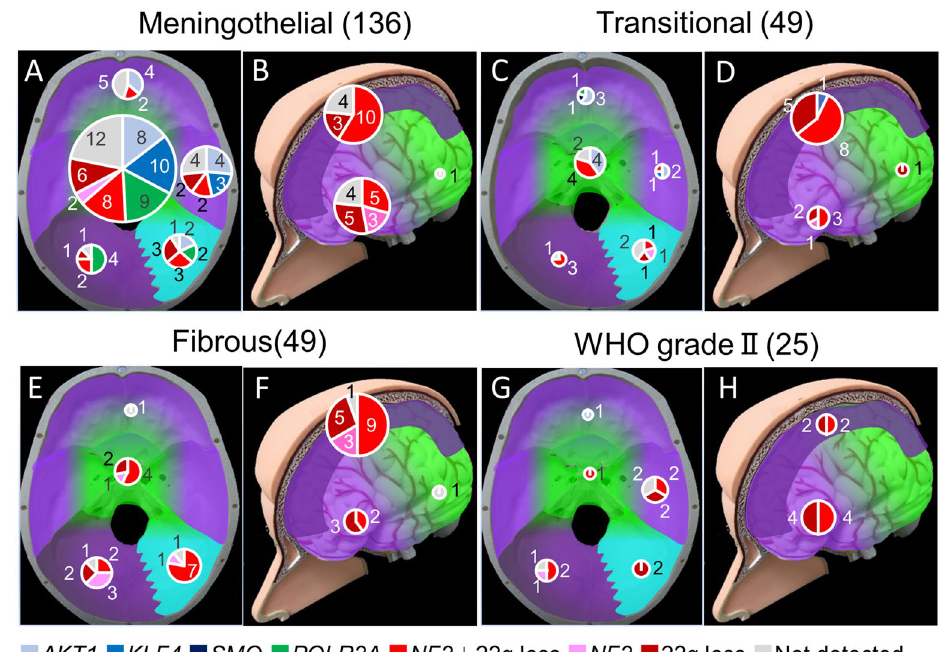
Figure 5. Associations between genetic mutations, histological type, and tumor locations. Each pie chart shows the breakdown of patients harboring each type of mutation. The size of pie charts reflects the total number of patients harboring each type of lesion. ( A ) Meningothelial tumor in the skull base. ( B ) Meningothelial tumor in the supra tentorial region. ( C ) Transitional tumor in the skull base. ( D ) Transitional tumor in the supra tentorial region. ( E ) Fibrous tumor in the skull base. ( F ) Fibrous tumor in the supra tentorial region. ( G ) WHO grade II tumor in the skull base. ( H ) WHO grade II tumor in the supra tentorial region. Figure generated using Microsoft PowerPoint 2016, https:// www. micro soft.